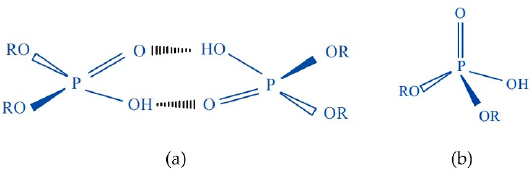
Figure 8. Proposed structure of ( a ) dimer of D2EHPA and ( b ) monomeric D2EHPA.